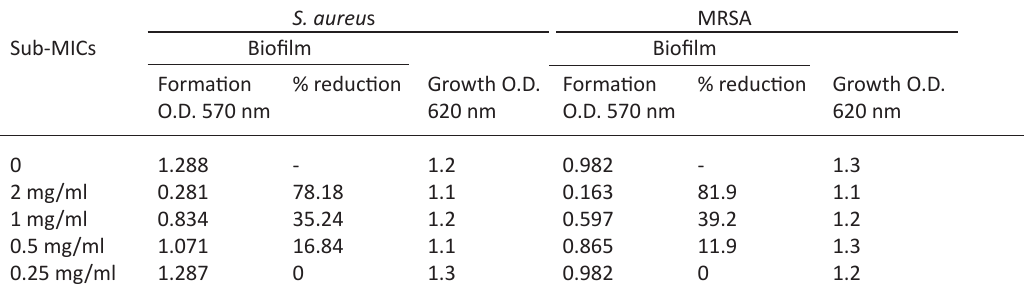
Table 5. Anti-biofilm effect of Z. spina-christi total extract on S. aureus and MRSA biofilm